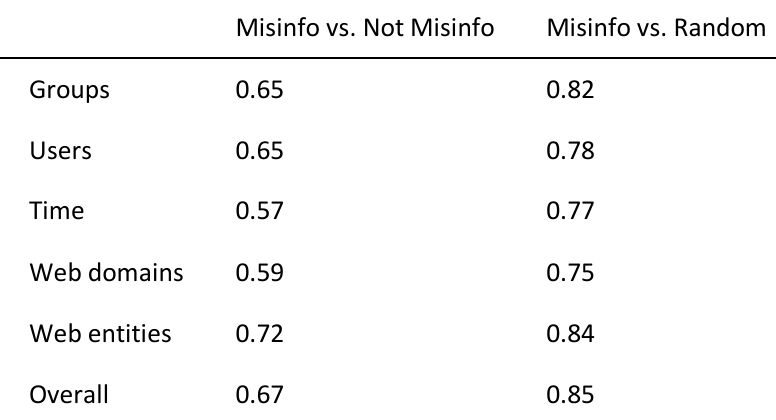
Table 2: Classification using metadata